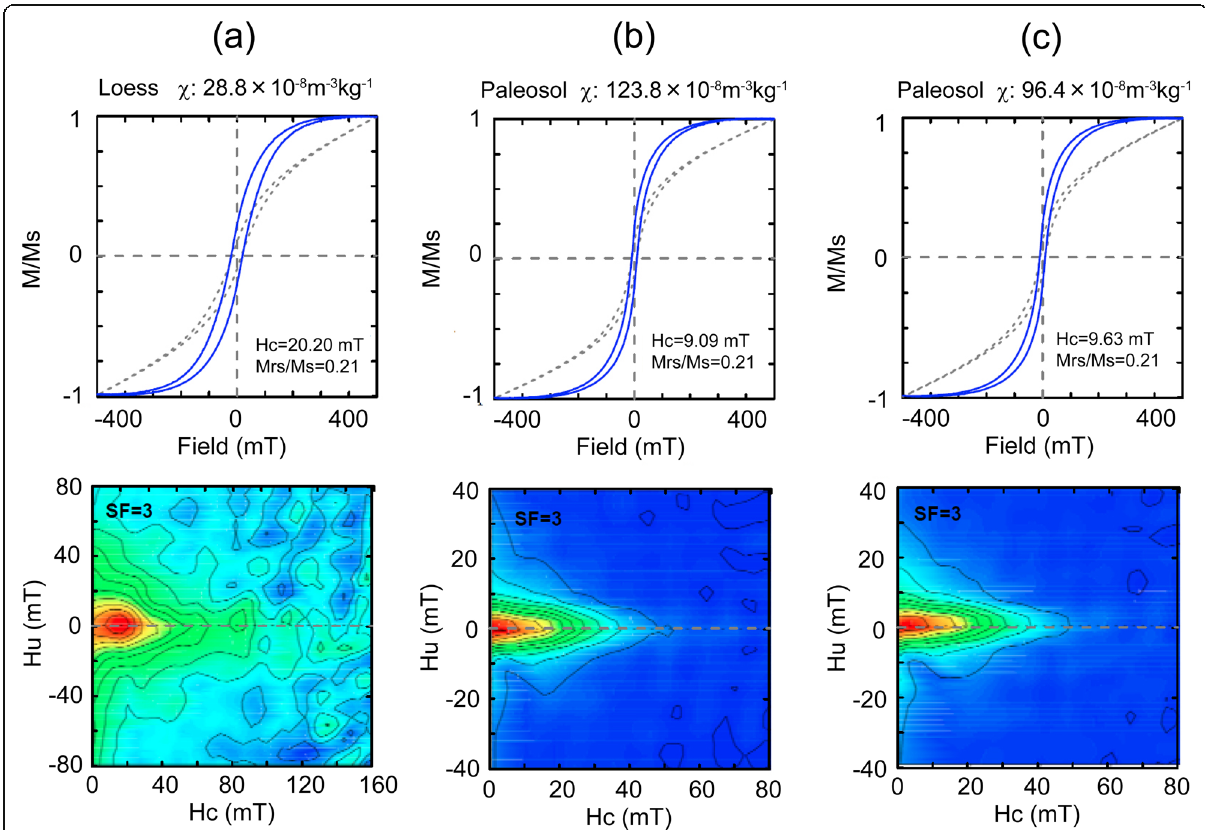
Fig. 2 Results of hysteresis and FORC measurements. The hysteresis curves and FORC diagrams are for loess ( a ) and paleosol ( b , c )